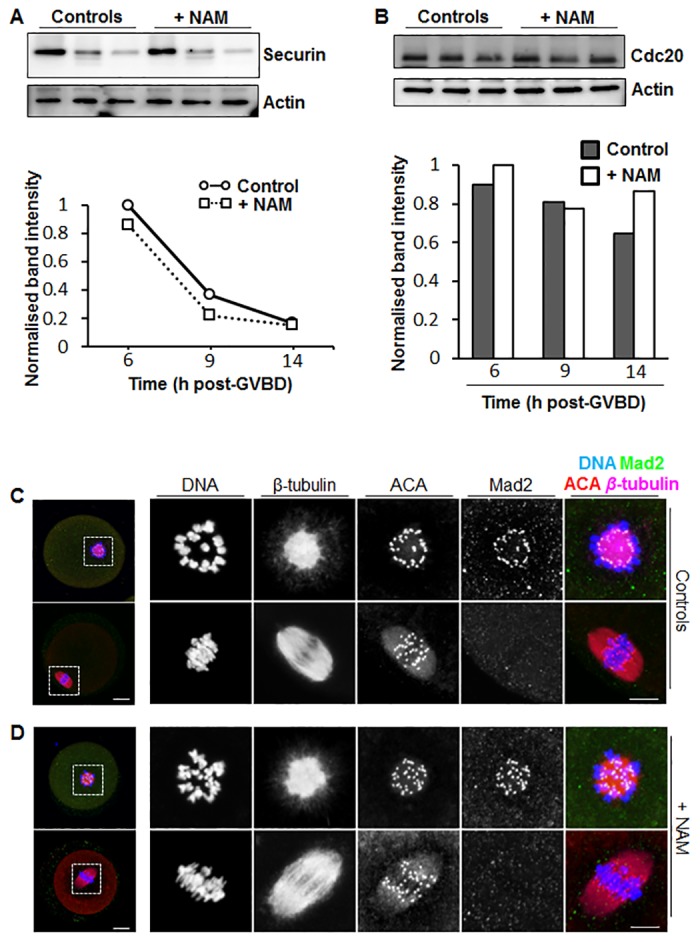
Effect of NAM treatment on securin and Cdc20 levels and kinetochore Mad2 localisation during meiosis I.(A) Western blot of securin and actin in control and NAM-treated oocytes at 6 h, 9 h and 14 h post-GVBD (30 oocytes per sample; shown is a representative blot of 3 replicates). Band intensities from Westerns were quantified and normalised against the maximal intensity at 6 h post-GVBD and plotted as a graph. (B) Western blot of Cdc20 and actin in control and NAM-treated oocytes at 6 h, 9 h and 14 h post-GVBD (30 oocytes per sample; shown is a representative blot of 3 replicates). Band intensities from Westerns were quantified and normalised against the maximal intensity at 6 h post-GVBD. (C, D) Changes in kinetochore Mad2 levels during meiosis I. Immunofluorescence staining for chromosomes (DNA), kinetochores (ACA), Mad2 and spindle microtubules (β-tubulin) at 2 h (upper panels) and 8 h (lower panels) post-GVBD in controls (C), and NAM-treated (D) oocytes. Note that at 2 h post-GVBD when spindles are at the ball stage, kinetochores recruit high levels of microtubules and that by 8 h post-GVBD when a bipolar spindle is present, Mad2 is undetectable at kinetochores in both groups. Panels to the extreme left are whole-oocyte images whilst panels to the right are magnified images of the regions enclosed by the dashed white squares. Scale bars = 10 μm.